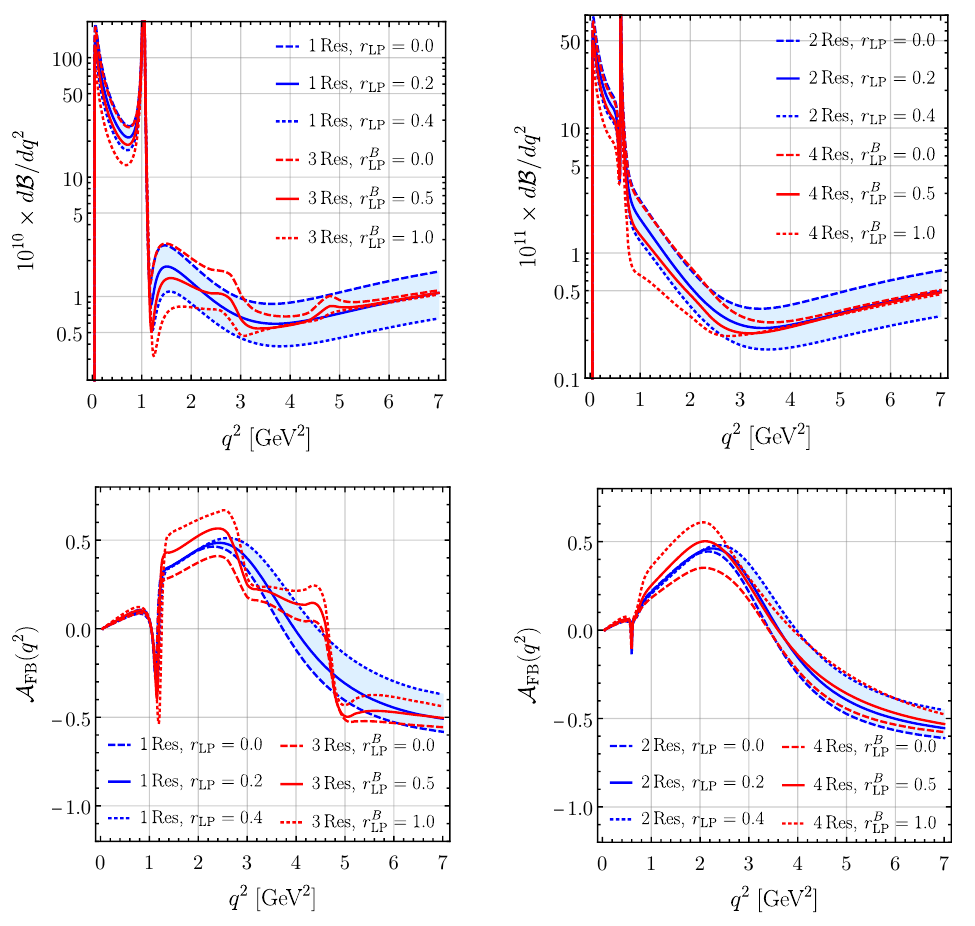
Figure 11 . Comparison of the 1(2)-Res model with a continuum of r LP = 0 . 2 ± 0 . 2 [blue] with the 3(4)-Res model for different values r B [lower] in B s → γµ ¯ µ [left] and B d → γµ ¯ µ